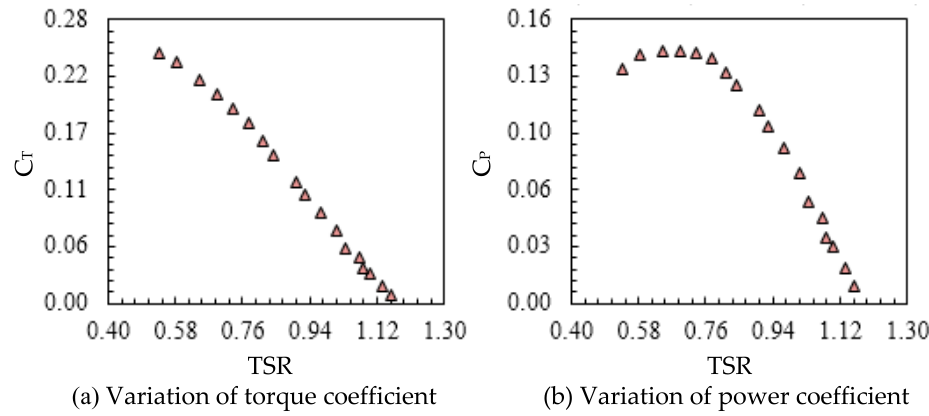
Figure 8. Performance parameters.